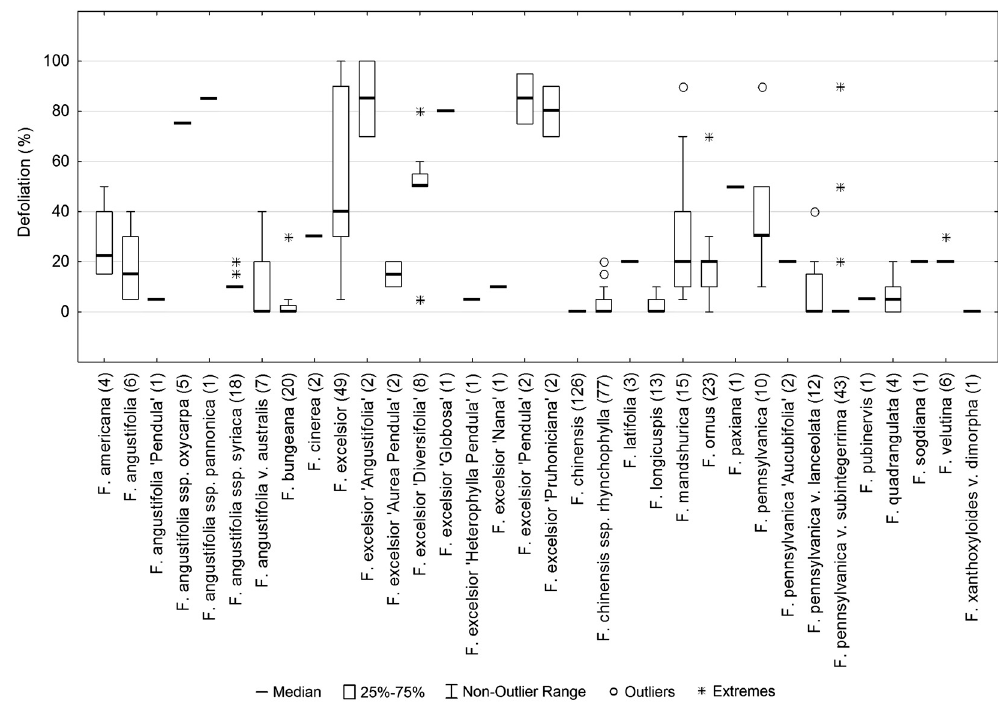
Figure 4. Crown defoliation (in percentages) of Fraxinus taxa in four Slovak arboreta. The number of assessed trees is enclosed in parenthesis after the taxon name.